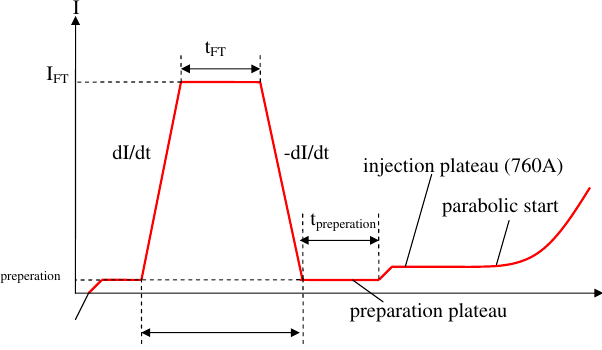
FIG. 5. (Color) Definition of the parameters affecting decay amplitude during LHC